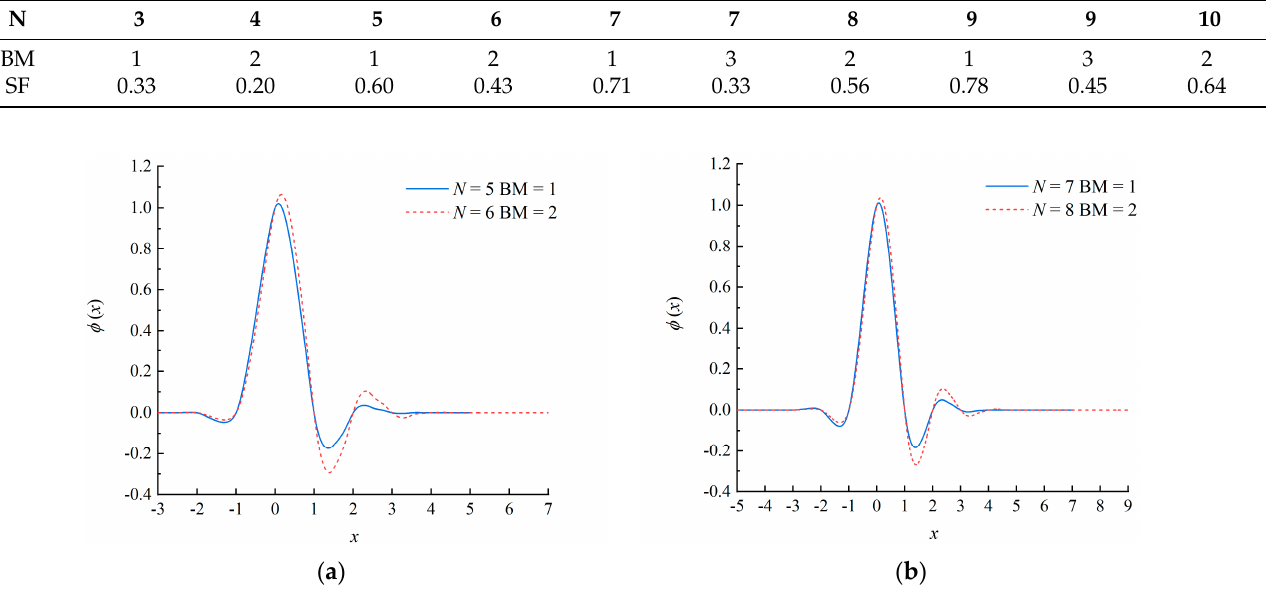
Figure 2. Examples of some asymmetrical scaling functions: ( a ) Scaling functions with N = 5 and N = 6; ( b ) Scaling functions with N = 7 and N = 8.